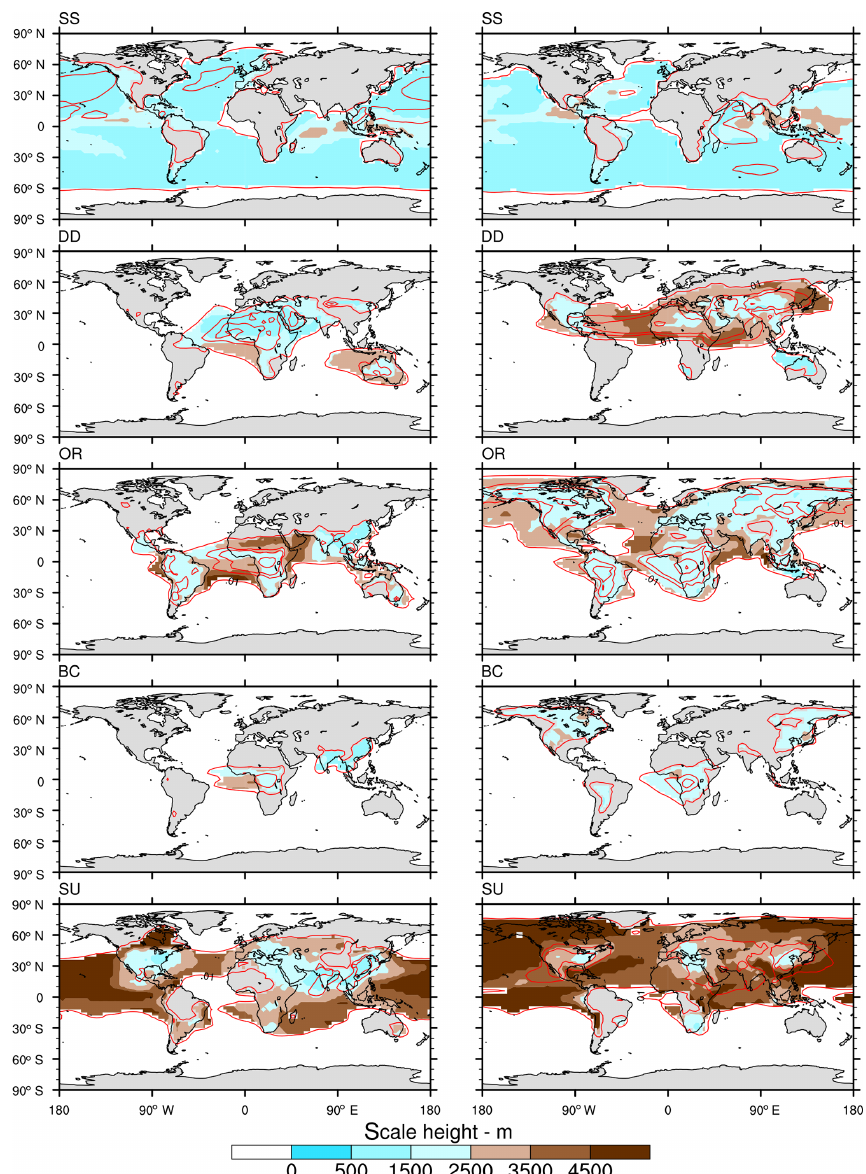
Figure A1. Scale height (colour shade) and AOT (red contours) for each aerosol type for January (left) and July (right) computed from the CAMS Control Run over the years 2003–2013 and with the total AOT scaled to preserve the CAMS reanalysis total AOT. The scale height is shown only for the grid points with an AOT for that aerosol type that is larger than 0.01. Contour lines values are 0.01, 0.05, 0.1, 0.4, 0.8 and